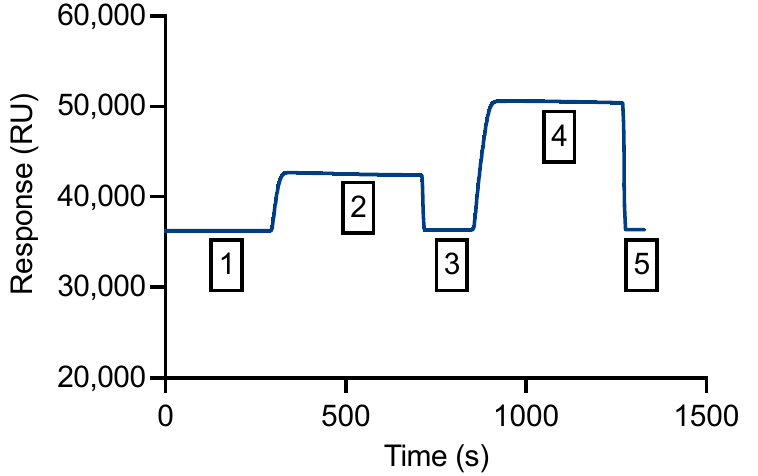
Figure 5. The validation of the SPR assay to measure the binding affinity of CFA and Ro 61-8048 to the recombinant KMO protein. KMO protein was immobilized on the SPR chip and HBS-EP+ (10 mM; 0.02 M HEPES, 0.3 M NaCl, 0.006 M EDTA, 0.1% v / v surfactant P20; pH 7.4) was used as the running buffer. Around 3200 RUs of the recombinant KMO protein were immobilized on the flow cell 2. Blank immobilization was performed on the flow cell 1. Immobilization phases 1–5 are represented as numbered boxes.